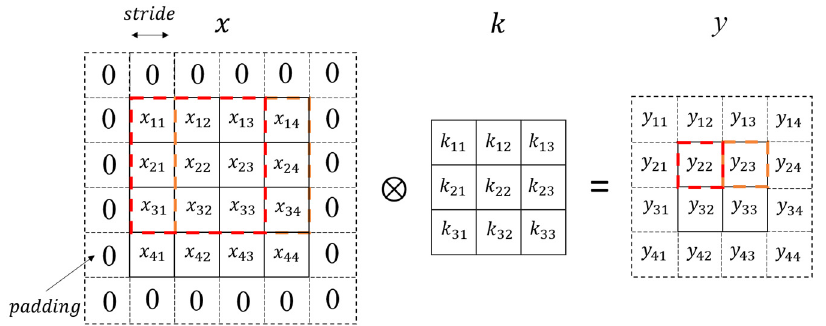
Figure 7. Schematic of the convolution operation. x is the input, k is the convolution kernel, y is the output. Zeros around the input are padding. The orange and red squares represent corresponding input and output cells of the first and second convolution operation, respectively.